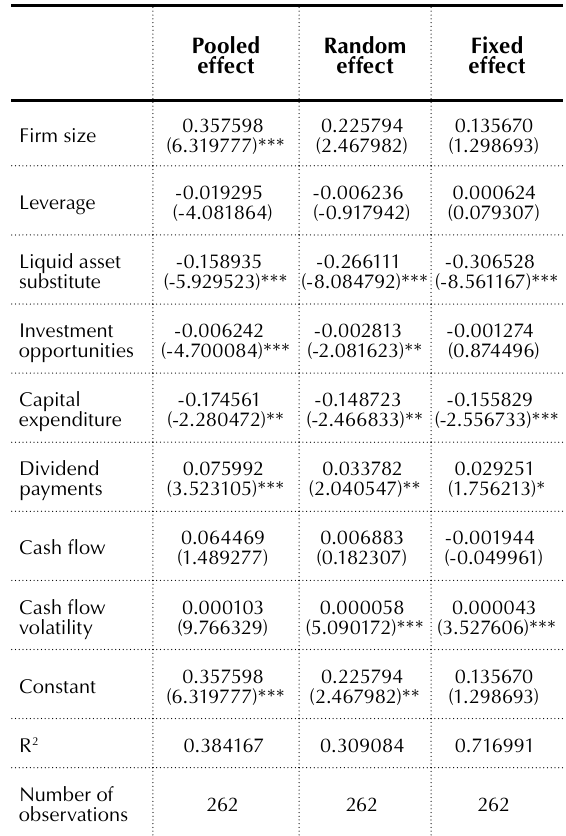
Table 4. Comparison of